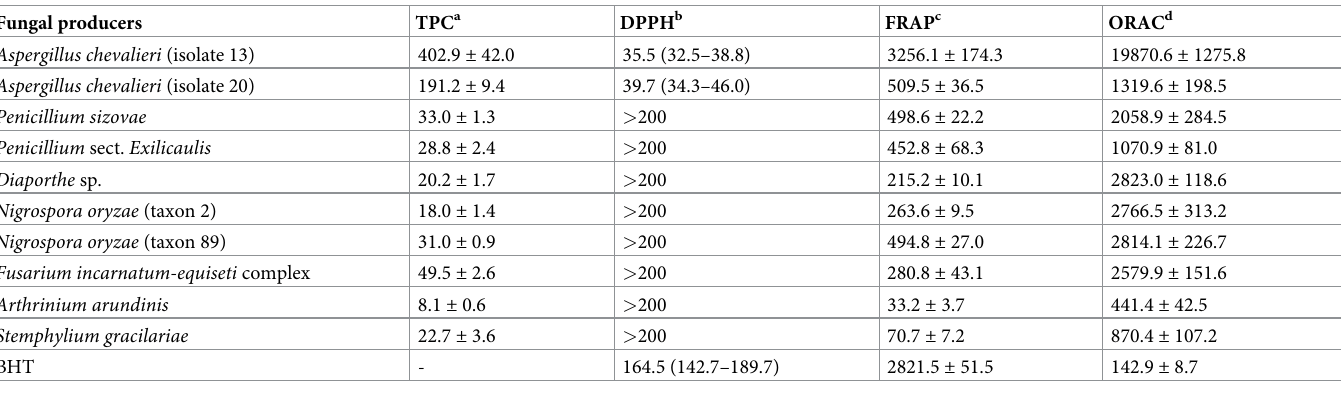
Table 2. Total phenolic content and antioxidant capacity of the crude extracts obtained from marine endophytic fungi associated with Halopteris scoparia . Fungal